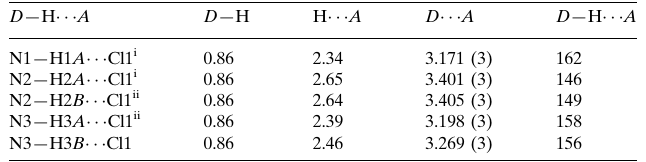
Hydrogen-bond geometry (A˚ , (cid:3)